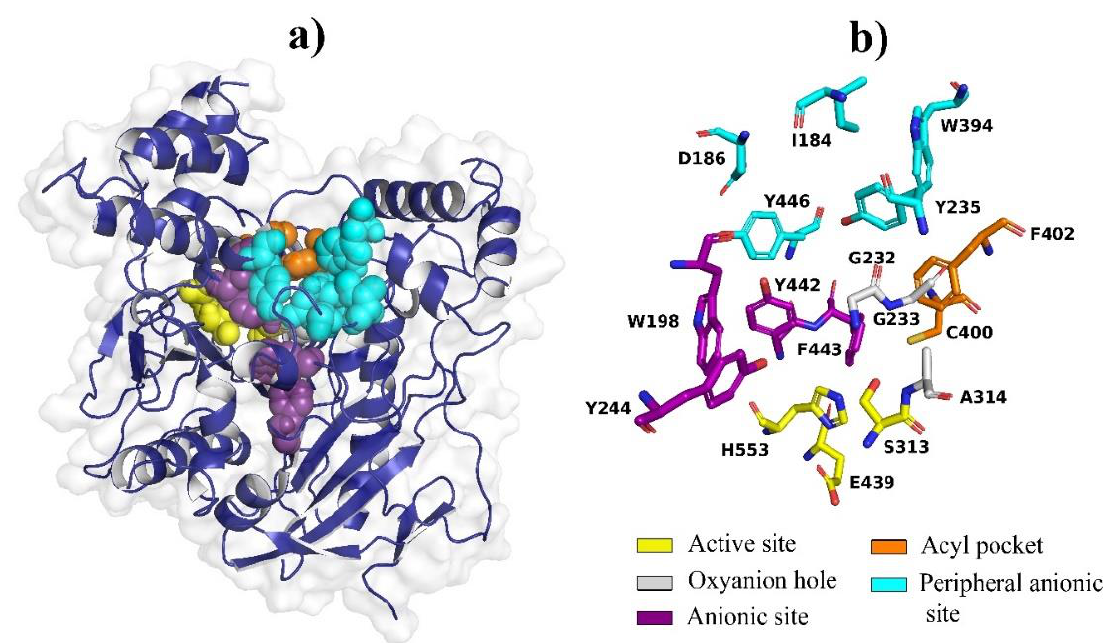
Figure 3 . Homology modeling of the S. frugiperda AChE protein. ( a ) Prediction of the 3D structure of AChE and ( b ) identification of amino acid residues on the active site.